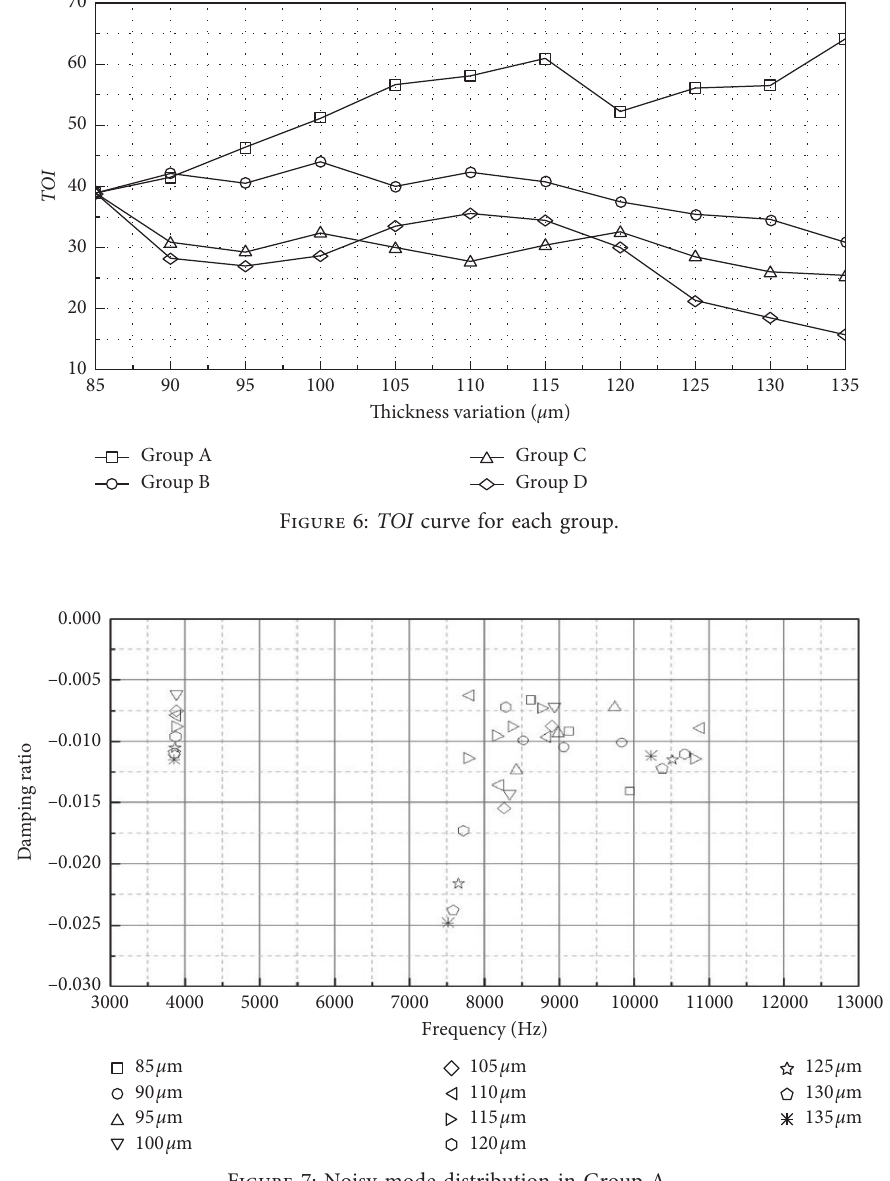
Figure 7: Noisy-mode distribution in Group